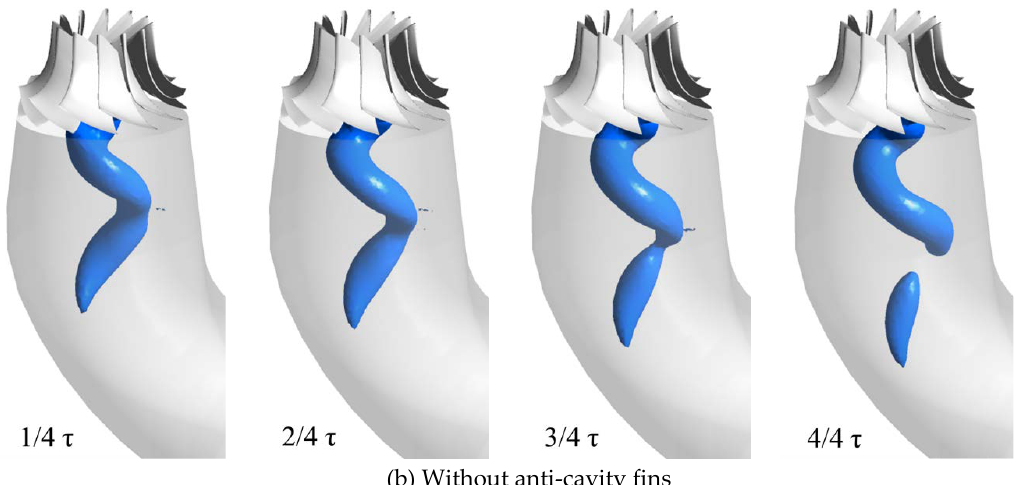
Figure 8. Iso-surface distributions of pressure in the DT during one runner revolution at a GV of 16°: (a) with anti-cavity fins; and (b) without anti-cavity fins.